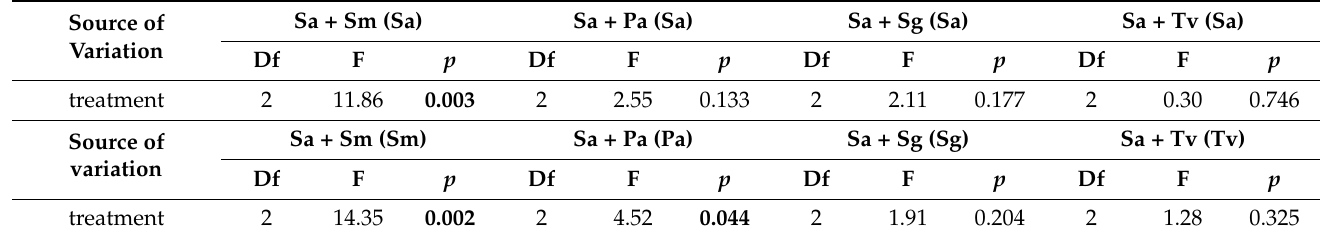
Table 1. Results of one-way ANOVA testing the effects of interspecific interaction treatment on seed germination percentage of invasive Spartina alterniflora (Sa) and four native species ( Scirpus mariqueter , Sm, Phragmites australis , Pa, Suaeda glauca , Sg, and Tripolium vulgare , Tv) seeds in different species combinations. The abbreviations in brackets after species combinations denote the target species considered. Significant p values are in bold.